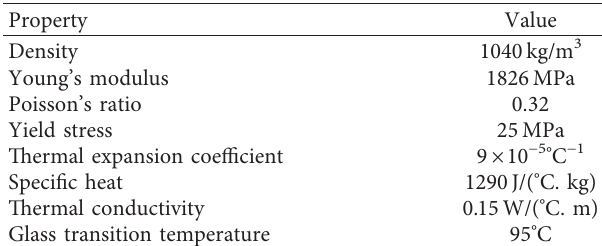
Table 11: Mechanical and thermal properties of the ABS at the ambient